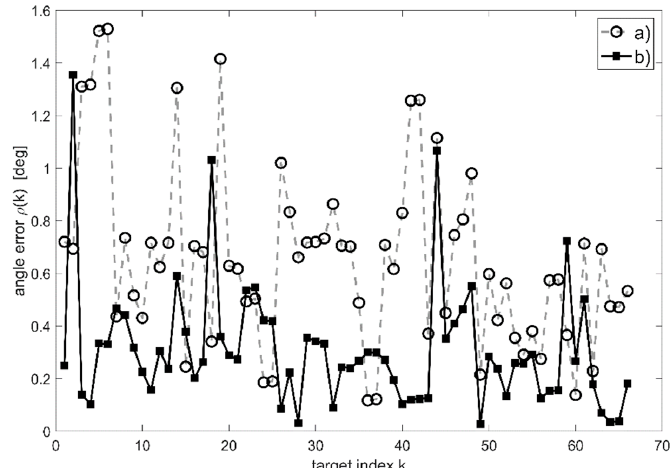
Figure 9. Target orientation error calculated from data acquired in [16] with the motion capture system: ( a ) uncorrected error 𝜌 (cid:3048)(cid:3041)(cid:3030) ; ( b ) corrected error 𝜌 (cid:3030)(cid:3042)(cid:3045) .